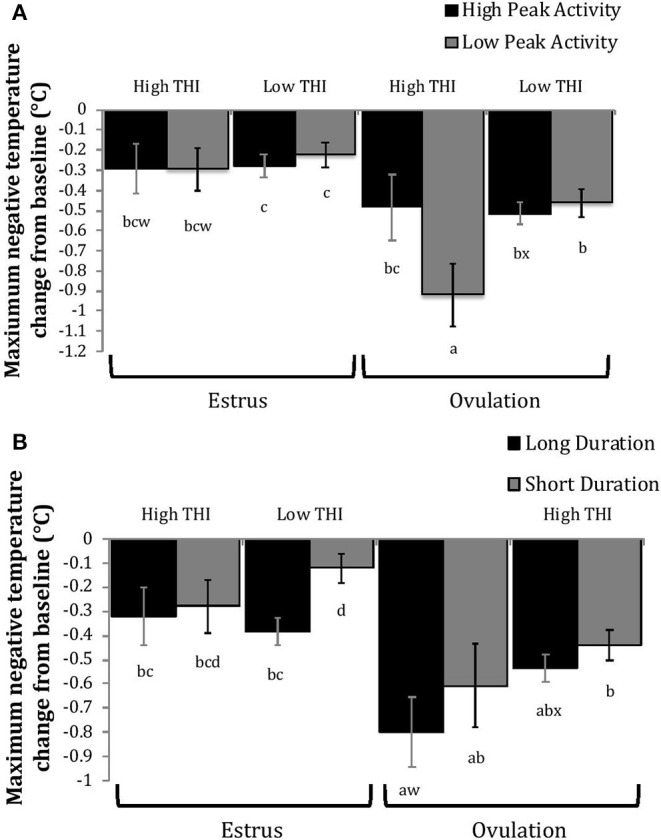
Maximum negative change in rumen-reticular temperature (least squared means ± SE) by sampling time (at the time of estrus or ovulation), THI and peak activity [(A); P = 0.21], or duration [(B); P = 0.37] obtained from a mixed linear regression model as described in Table 1. Superscripts of letters a-d denote significant differences (P < 0.05), while letters w-x denote tendencies (0.05 ≥ P < 0.10), between all groups of each panel. High peak activity: estrous expression greater than the median of 80 index on the AAM. Low peak activity: estrous expression less than the median. Long duration: estrous expression lasting longer than the median of 12 h. Short duration: estrous expression lasting less than the median. High THI: Maximum THI >72. Low THI: Maximum THI <72. THI data was collected relative to the sampling time (estrus vs. ovulation).